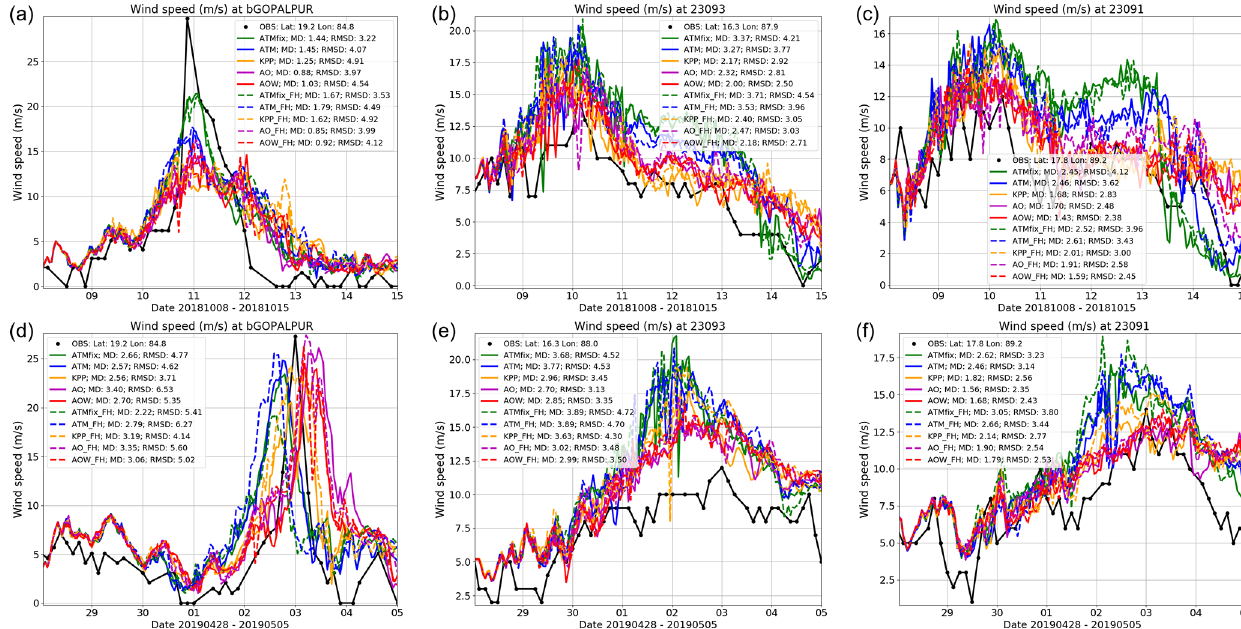
Figure 9. Comparison of observed (black lines) and simulated wind speed at (a, d) Gopalpur coastal location, (b, e) 23093 ocean buoy and (c, f) 23091 ocean buoy during (a–c) Titli, and (d–f) Fani case study periods. See Fig. 1 for summary of observation locations. Note that different y -axis scales are used in each panel. Simulation results without (solid lines) and with frictional heating (dashed lines) are provided, based on mean of 5 × 5 neighbourhood of grid points nearest the observation